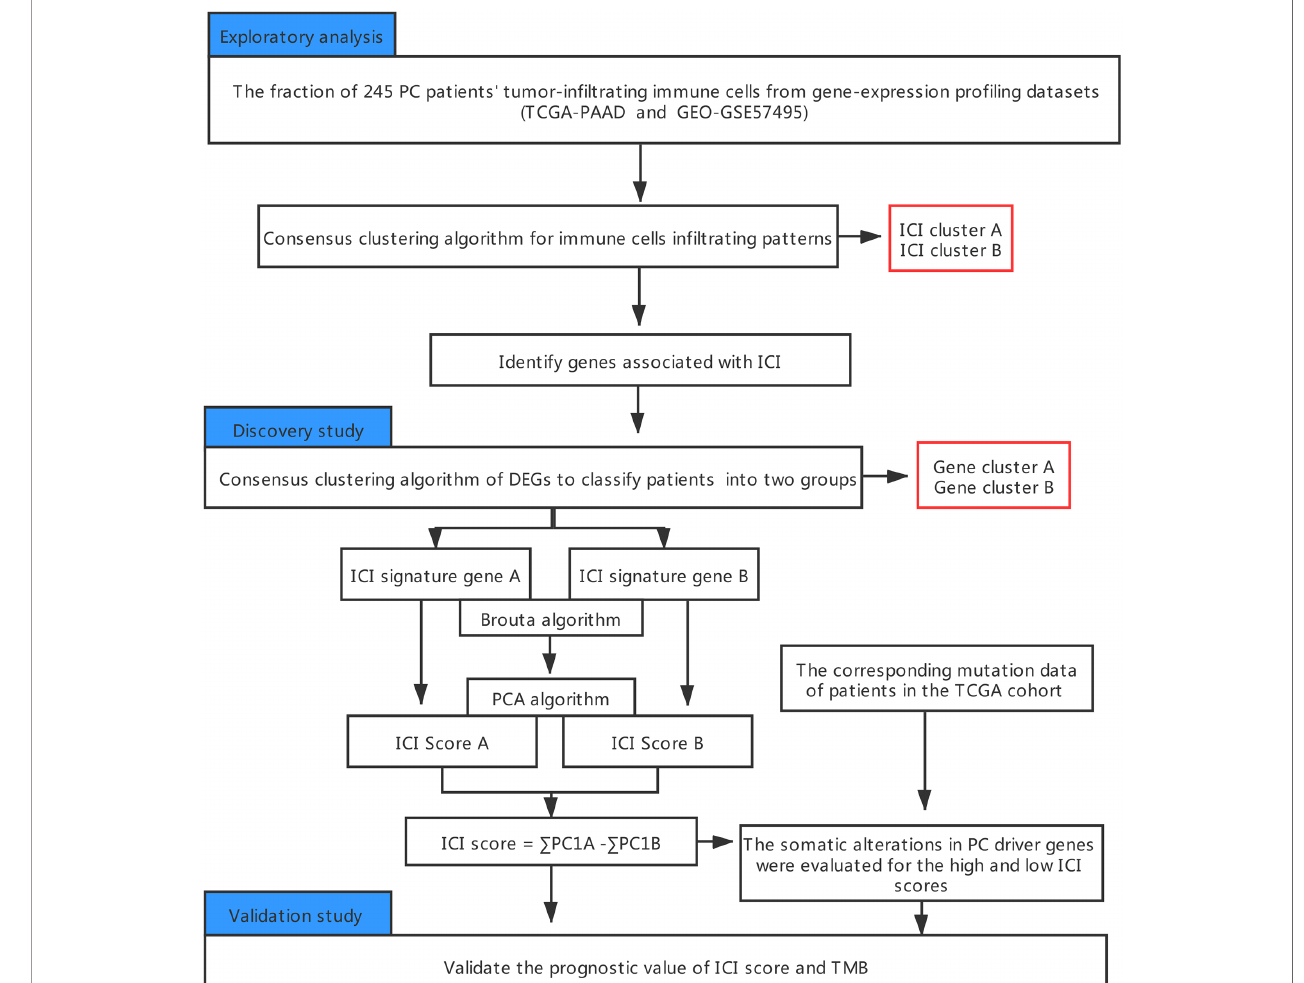
FIGURE 1 | An outline of the research and data collection